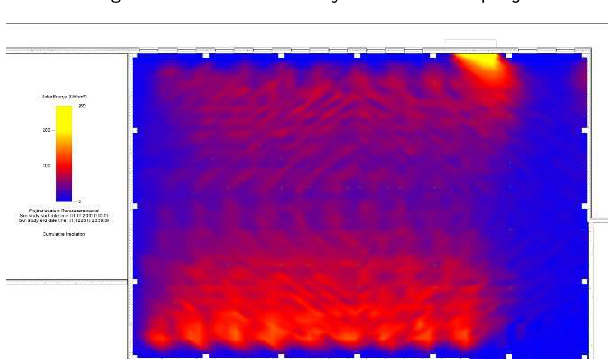
Figure 10. Cumulative insolation